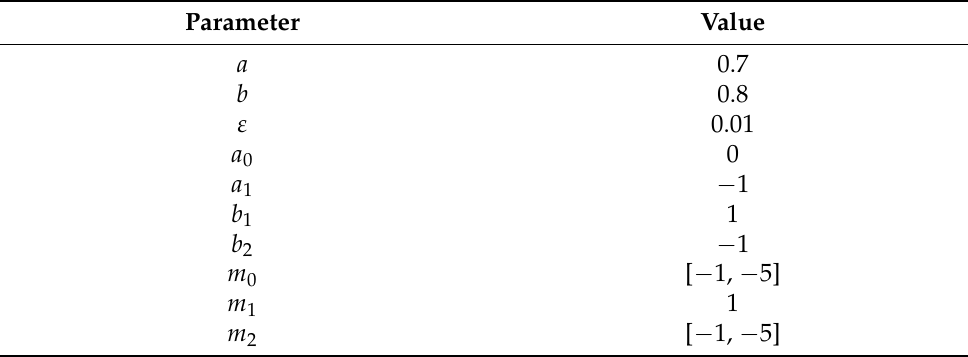
Table 1. FitzHugh–Nagumo Neuron (FHN) parameters.